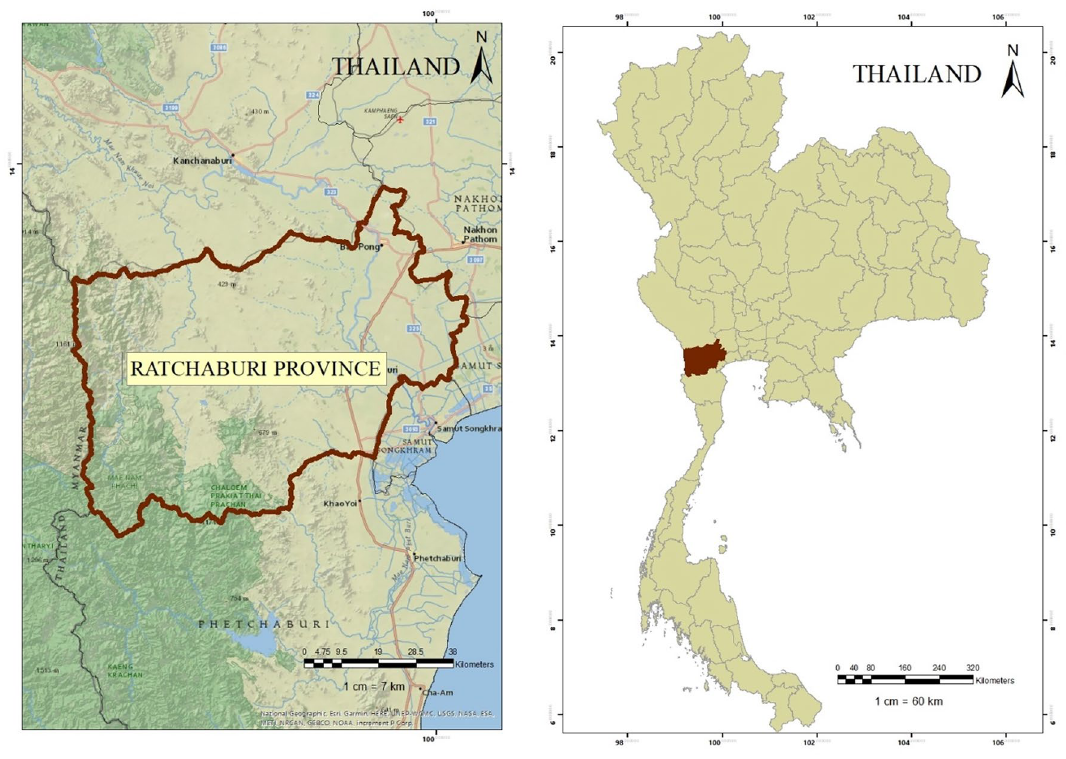
Figure 4. Location of sampling site in Ratchaburi province, Thailand.